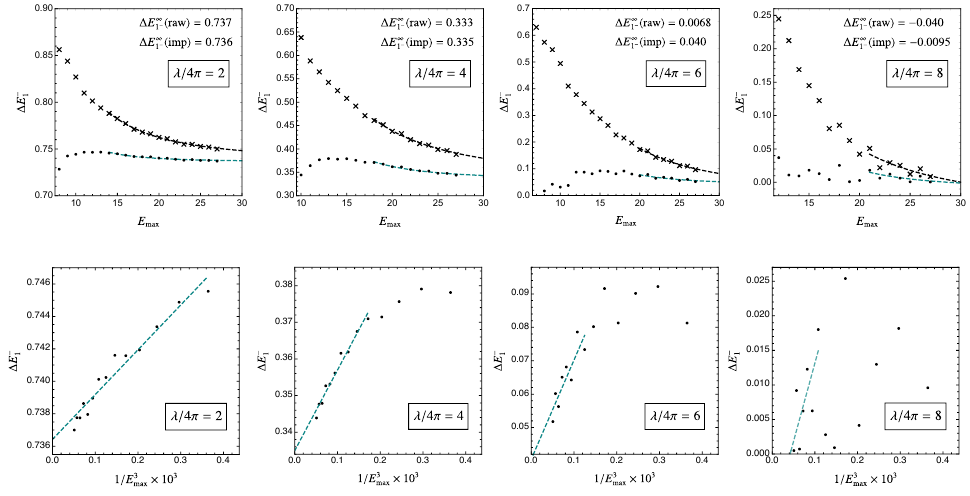
Fig. 7. The (cid:90) -odd ground state excitation energy ∆ E − 2 cutoff E for λ/ 4 π = 2,4,6,8. In all panels, m max E tails of ∆ E for the raw and improved theories are fit to 1 / E 2 max 1 respectively. The convergence is spoiled by numerical noise for larger values of λ .